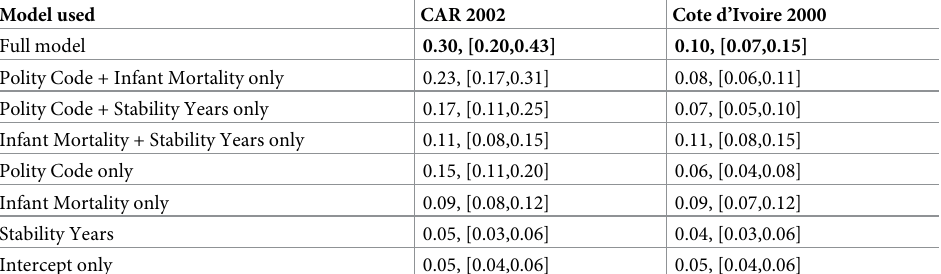
Table 5. Example predicted instability probabilities. Predicted probability of instability within two years for CAR and Cote d’Ivoire made by the full three predictor model and a series of nested models created by removing either one, two or three predictors from the full model (with 95%